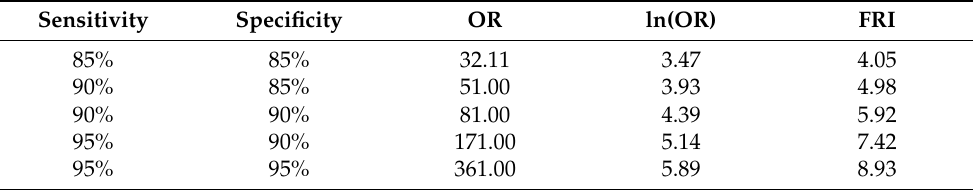
Table 3. Association between FRI and accuracy of automatic diagnosis by facial recognition. FRI = facial recognition intensity, OR = diagnostic odds ratio. Quantitative relationship between FRI and diagnostic accuracy (including Figure 2. in meta-analysis. ln (OR) = ln [Se Sp/(1 − Se) (1 − Sp)] = 0.4951 × FRI + 1.46.